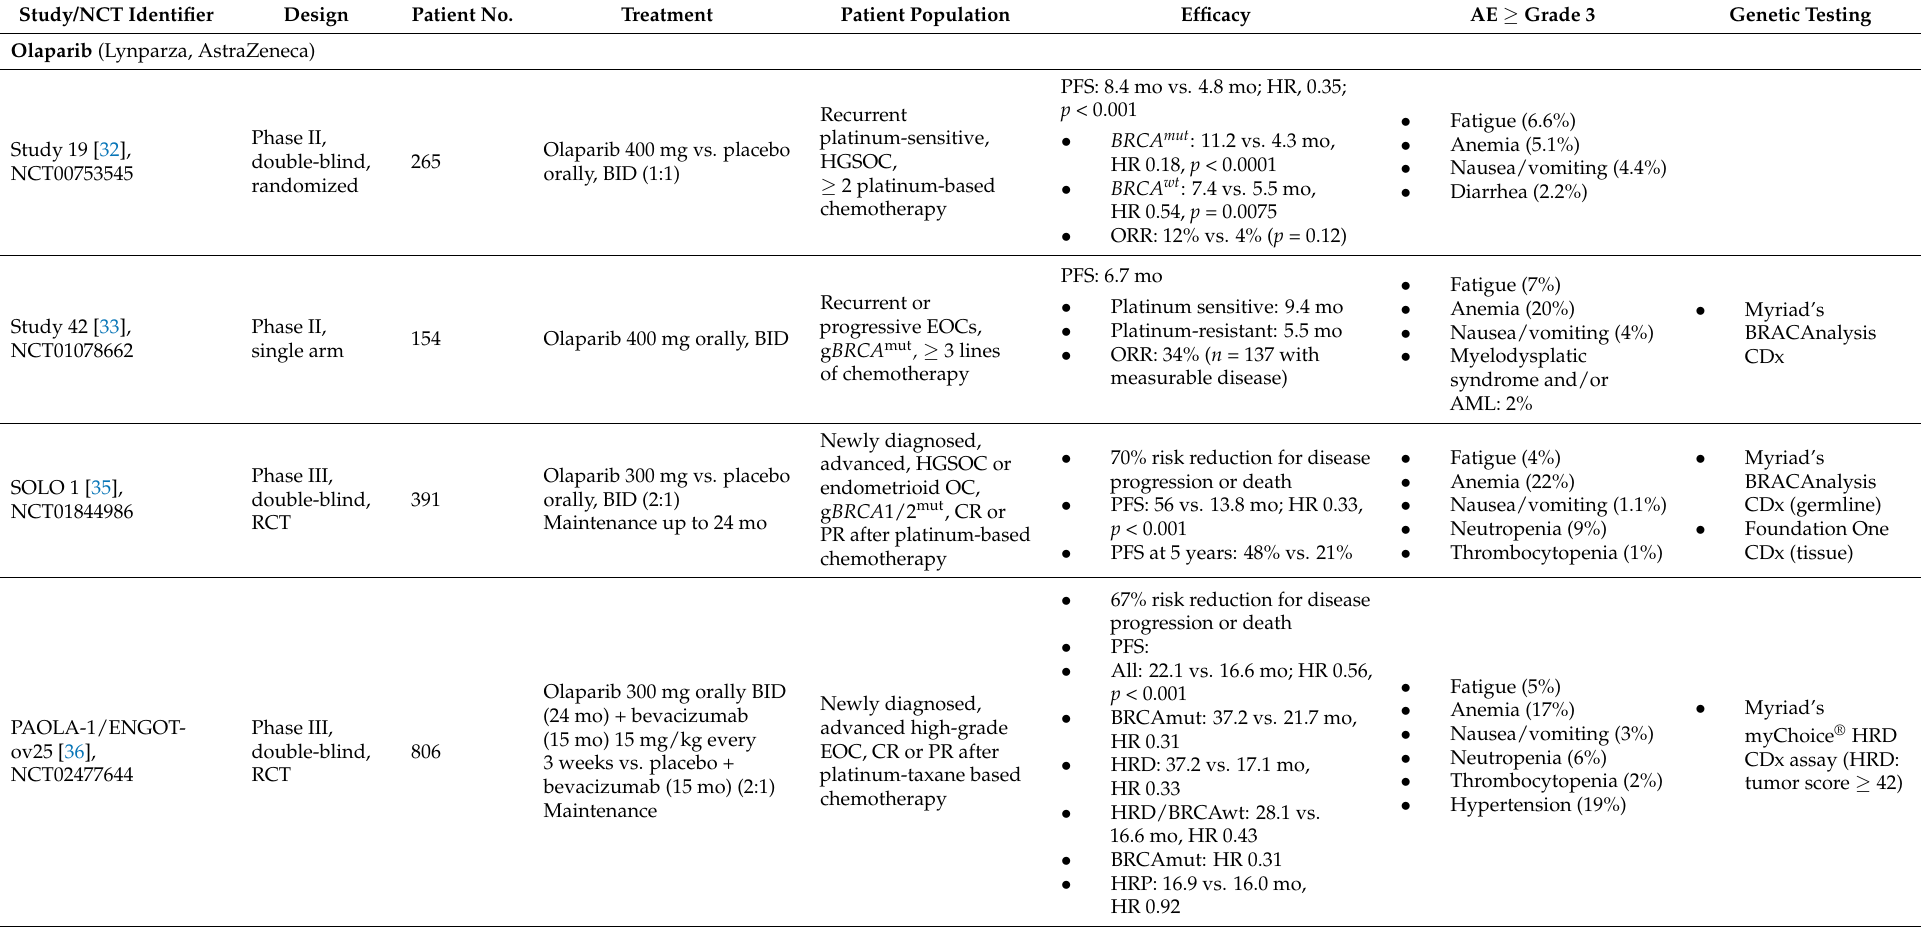
Table 1. Results of phase II/III clinical trials of PARP inhibitors in ovarian